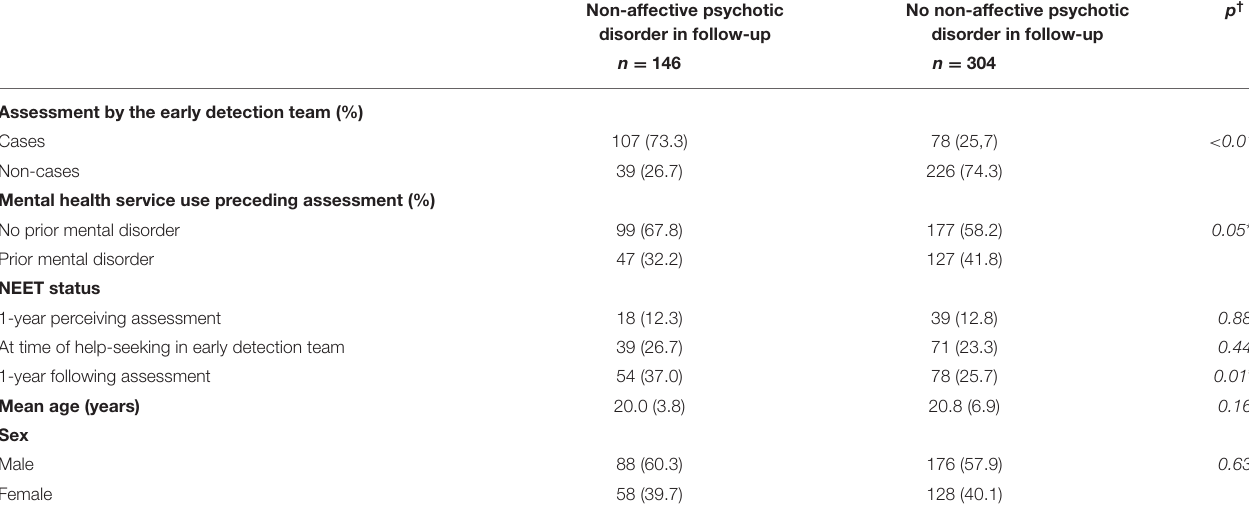
TABLE 3 | Socio-demographic and clinical characteristics of help-seekers diagnosed and not diagnosed with non-affective psychotic disorder in follow-up.